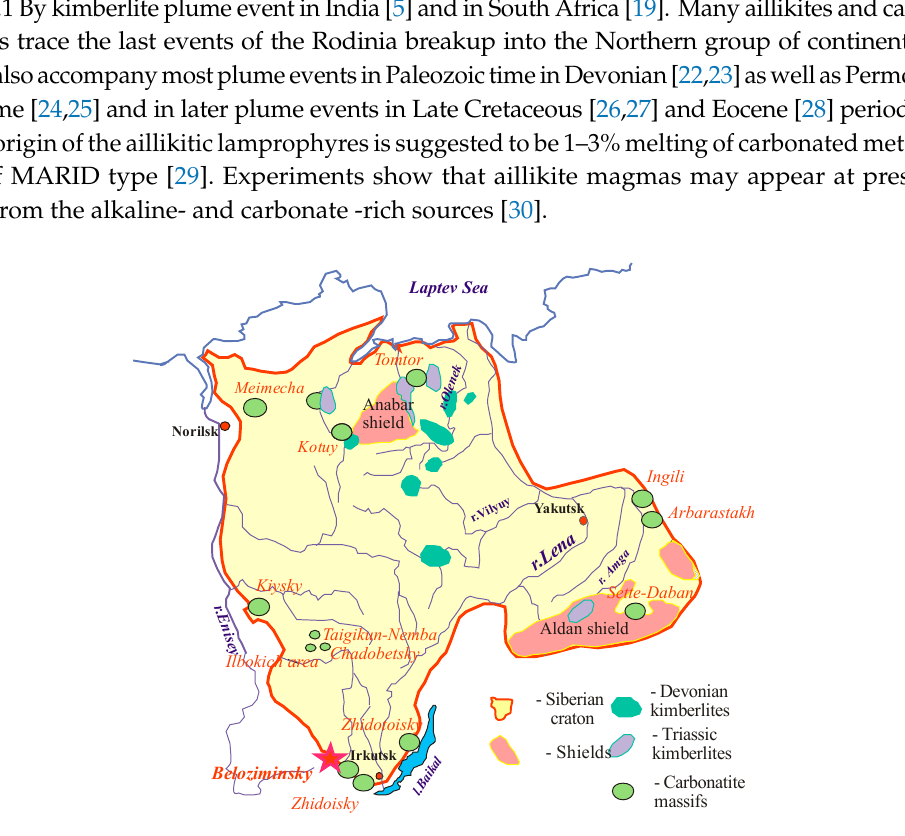
Figure 1. Location of the carbonatitic complexes on the Siberian craton.